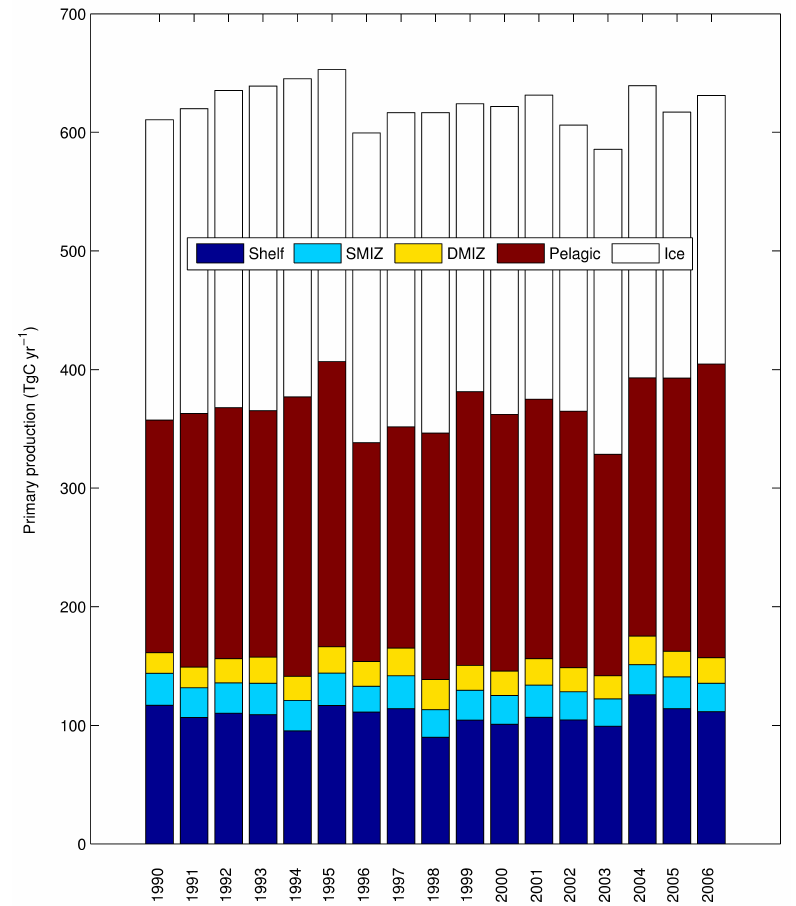
Fig. 6. Modelled annual primary production in the Arctic Ocean for each ecological province as defined in Sect. 2.5 during 1990–2006 (cf. Fig. 9 in Pabi et al. (2008)), TgCyr − 1